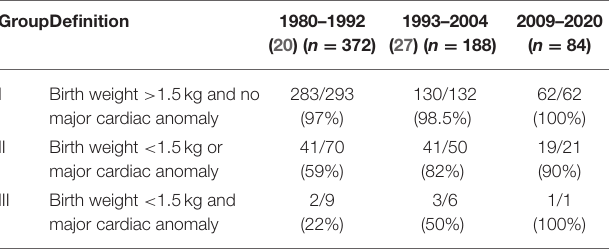
TABLE 4 | Mortality risk assessment